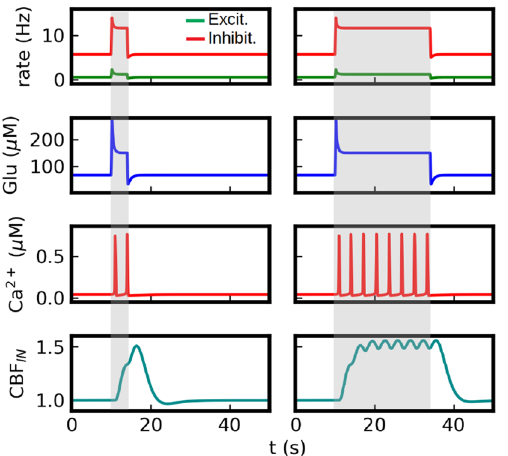
Figure 3. Time course of main model variables for a stimulus of 4 seconds (left) and 24 seconds (right). The interval of stimulus application is indicated by the grey area. The figure illustrates the calcium pathway of neurovascular coupling in the model. The stimulus (represented as an increase in the external input ν ext , not shown) generates an increase in neuronal activity (top panel) which induces a rise in the level of perisynaptic glutamate concentration (second panel). Glutamate triggers the activation of calcium dynamics in astrocytes which is characterized by brief calcium ’spikes’ as seen in the figure (third panels from the top). This leads to the production and release of the vasomodulator PGE2 (not shown, see Supp. Inf. Materials and Methods) which dilates the nearby arteriole and increases the flow of blood into the tissue (bottom panel). The simulations correspond to ν ext =4